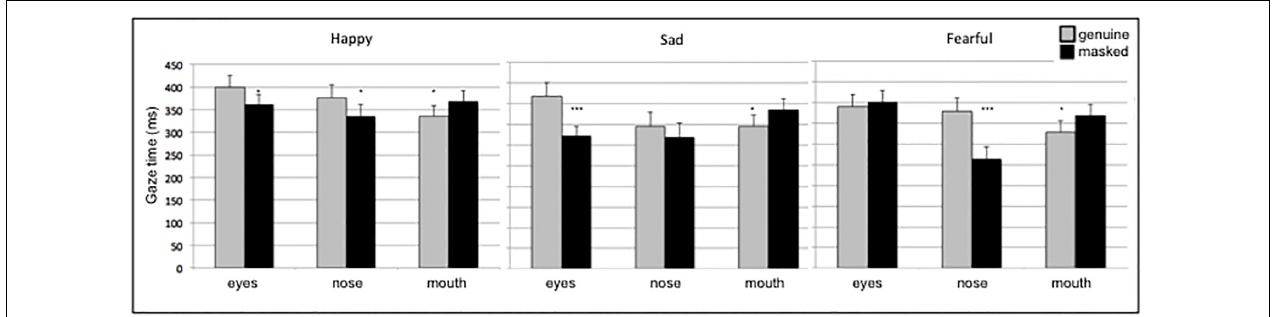
FIGURE 3 | The gaze time on eyes, nose and mouth ROIs. The gaze time duration as a function of region, emotion, and veracity. The error bars show standard error and statistical significance is marked by ∗ p < 0.5; ∗∗ p < 0.01; ∗∗∗ p <